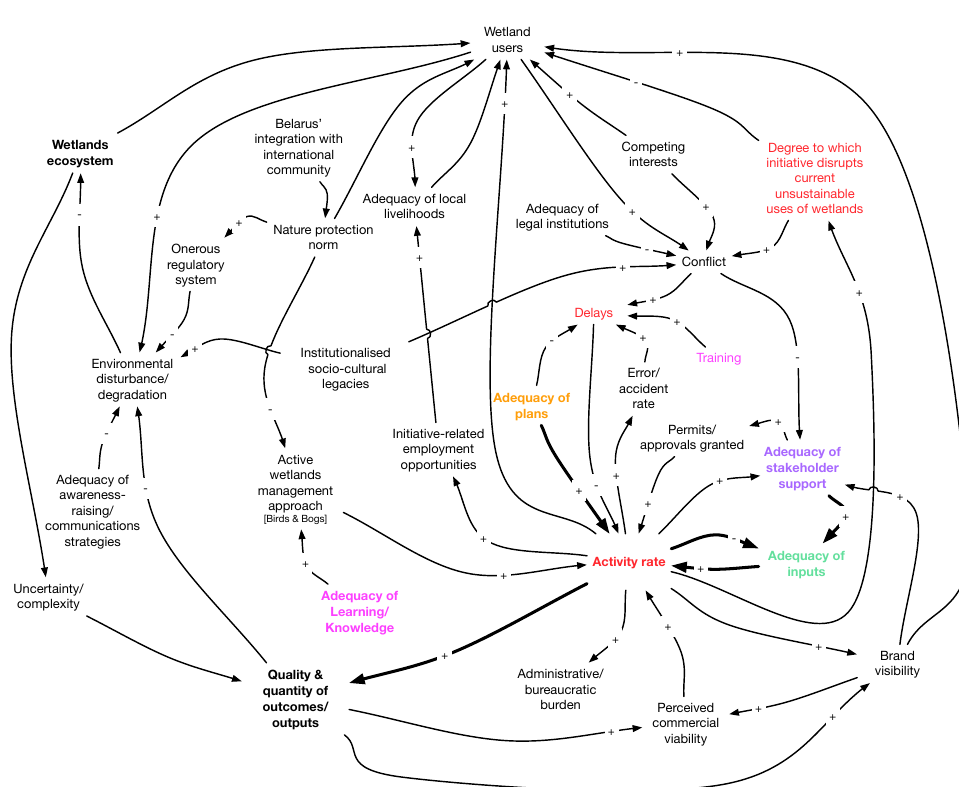
Figure 9 (from main paper). Sub-model unpacking causal dynamics influencing the Activity rate of wetland restoration initiatives in Belarus. Entrenched socio-cultural legacies of indifference and carelessness regarding the negative impacts of some users on wetlands were identified as a driver of environmental disturbance & degradation. Leader for all three cases sought therefore to shape public attitudes through a variety of direct awareness-raising and knowledge dissemination activities, and/or through indirect use of power, e.g. refusing to purchase unripe berries in order to affect change in picking behaviours. Brand visibility also influenced the number and types of